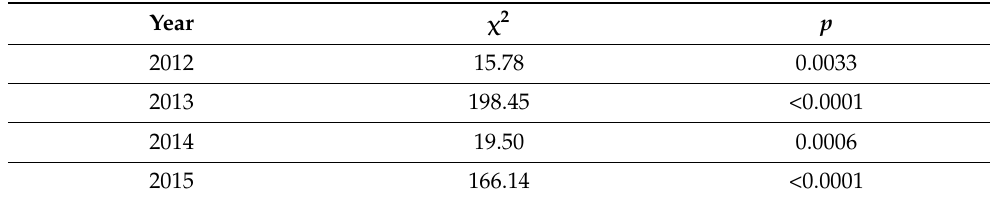
Table 2. Chi-squared test and p -values for comparing absolute frequencies of infestation levels in plots surrounded with (F) and without (NF) service plants (sweet alyssum, marigold, large-flowered tickseed, and yarrow) in each of the study years (2012–2015).